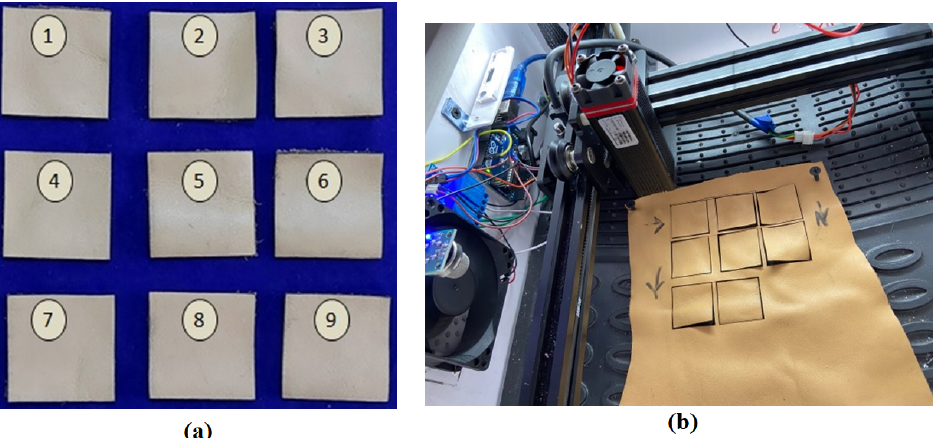
Figure 1. ( a ) Machined buffalo leather samples. ( b ) Leather cut performed using two-axis diode laser cutter.